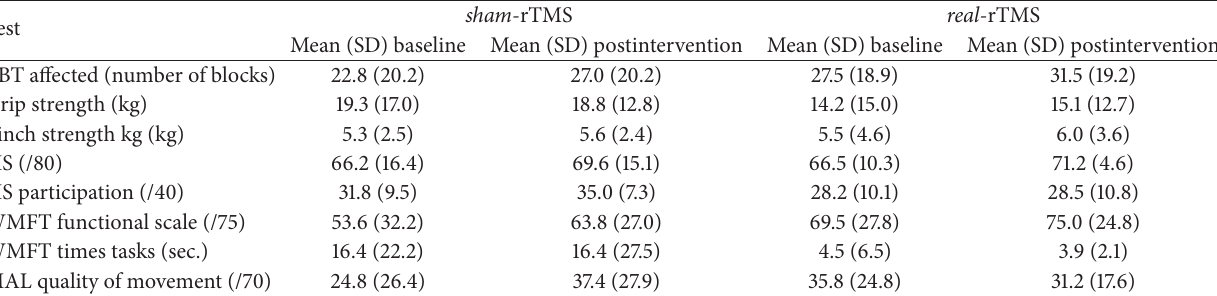
Table 2: Scores on measures of motor impairment and capacity at baseline, postintervention, and follow-up evaluations.